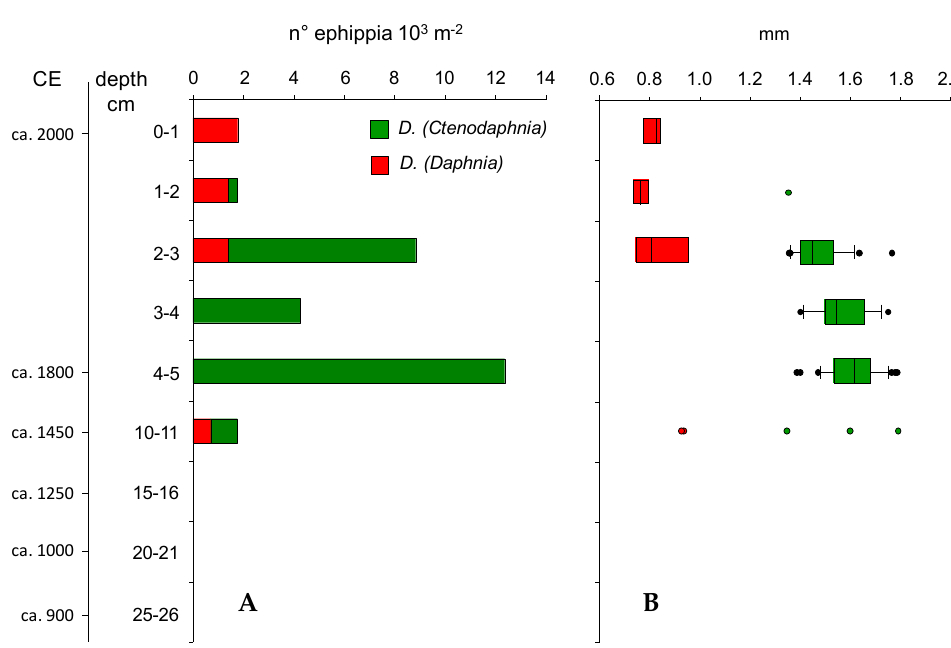
Figure 2. Abundance of ephippia in the analyzed sections of the sediment core 04/1 of LCN10 ( A ) and range of variation of their length ( B ). Vertical lines represent median values while horizontal whiskers represent the 95th percentile.